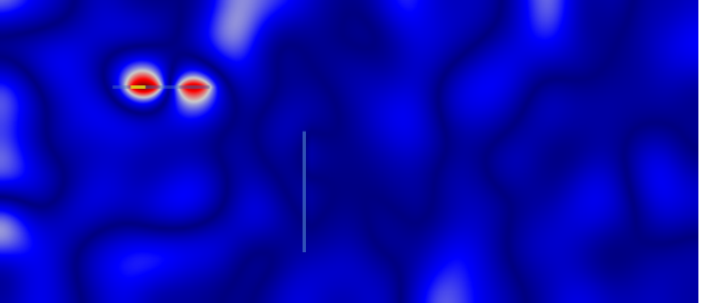
Figure 12. The absolute pressure on the whole domain at time 1.186ms. Beams are plotted with light blue color and the location of the defect is indicated with yellow color. Dipole-like pressure activity is evident at the vicinity of the damaged segment of the beam.